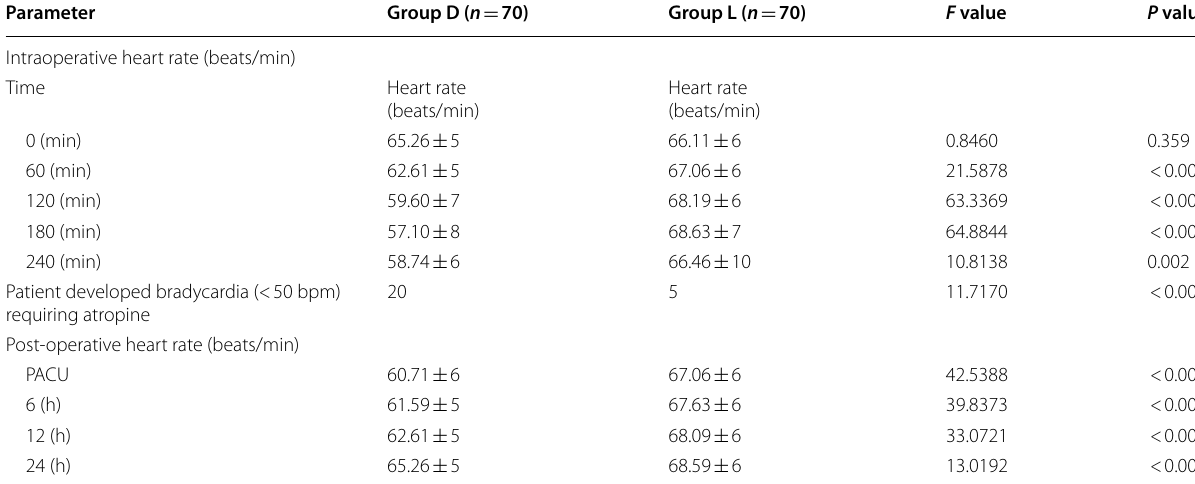
p value < 0.05 is considered significant